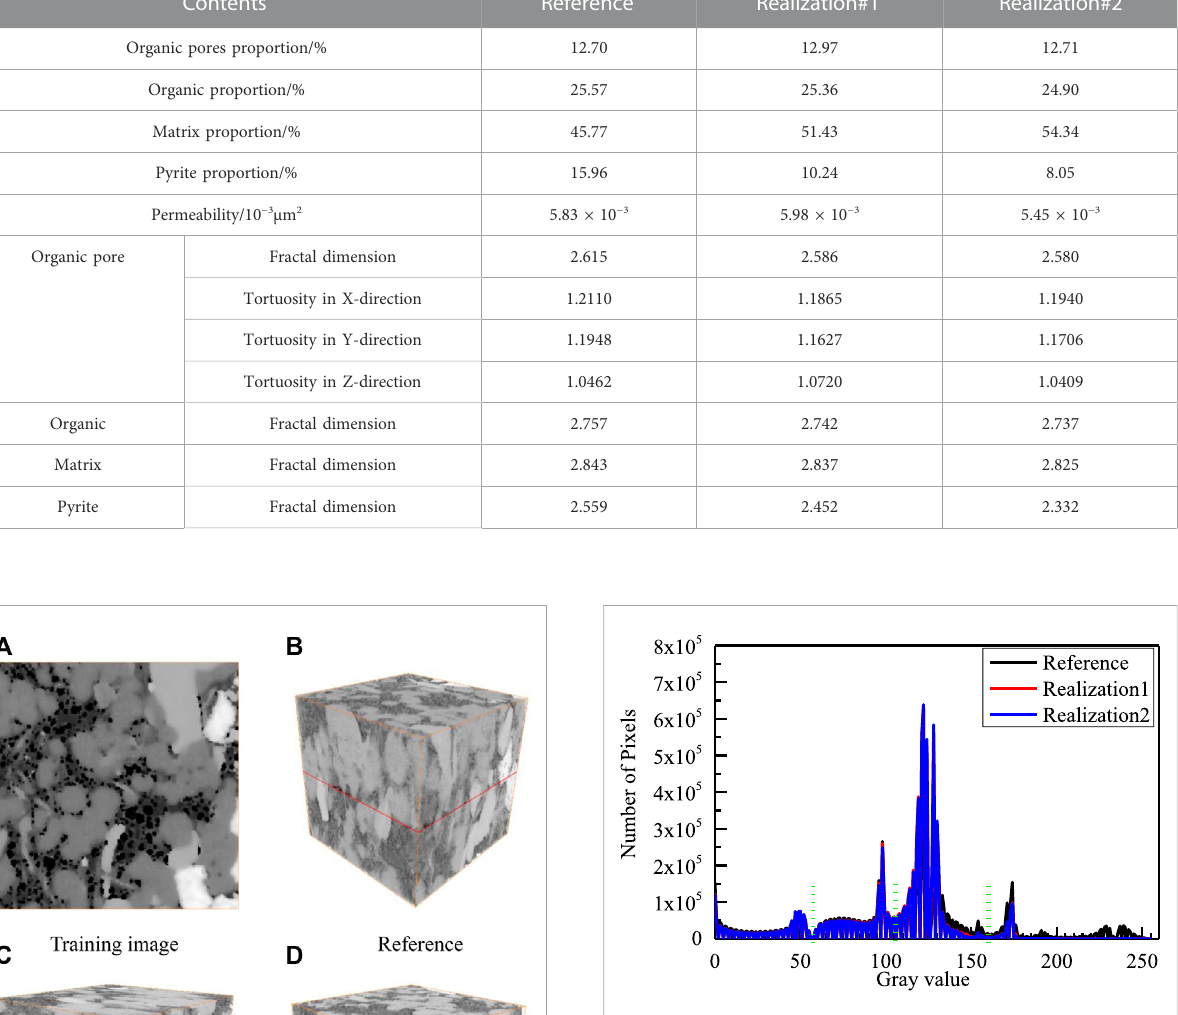
FIGURE 15 Comparison of the gray value distribution of the reference image and different realizations based on the proposed approach. The green dotted line is the gray value used to segment 3D shale gray digital rocks to obtain 3D shale segmented digital